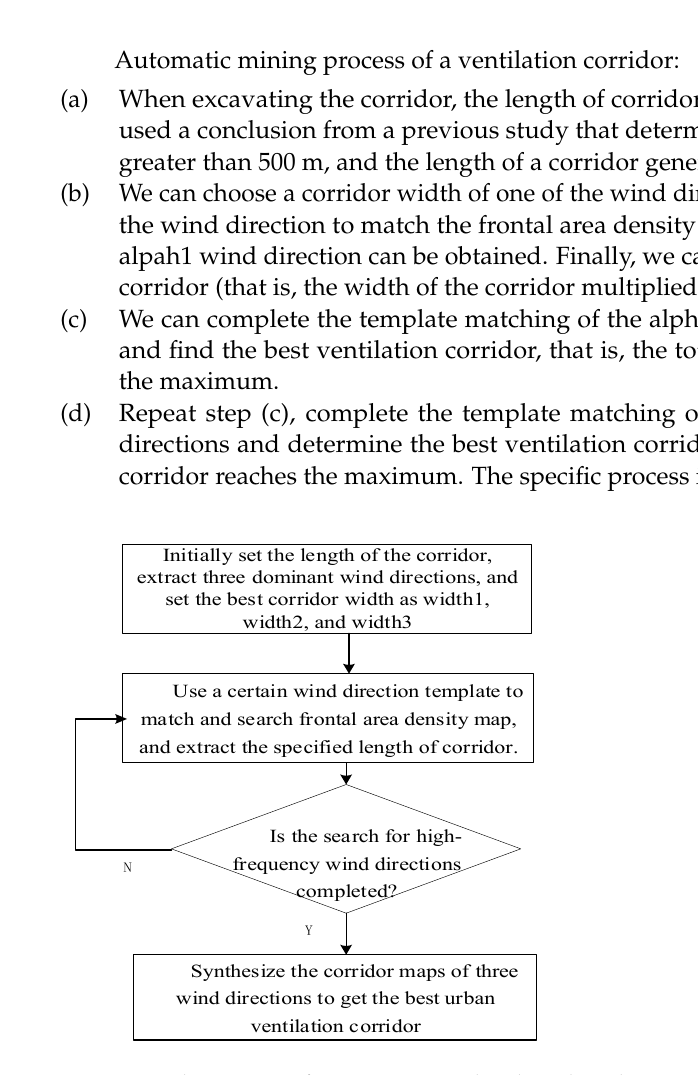
Figure 13. The process of extracting corridors based on the optimal corridor width.